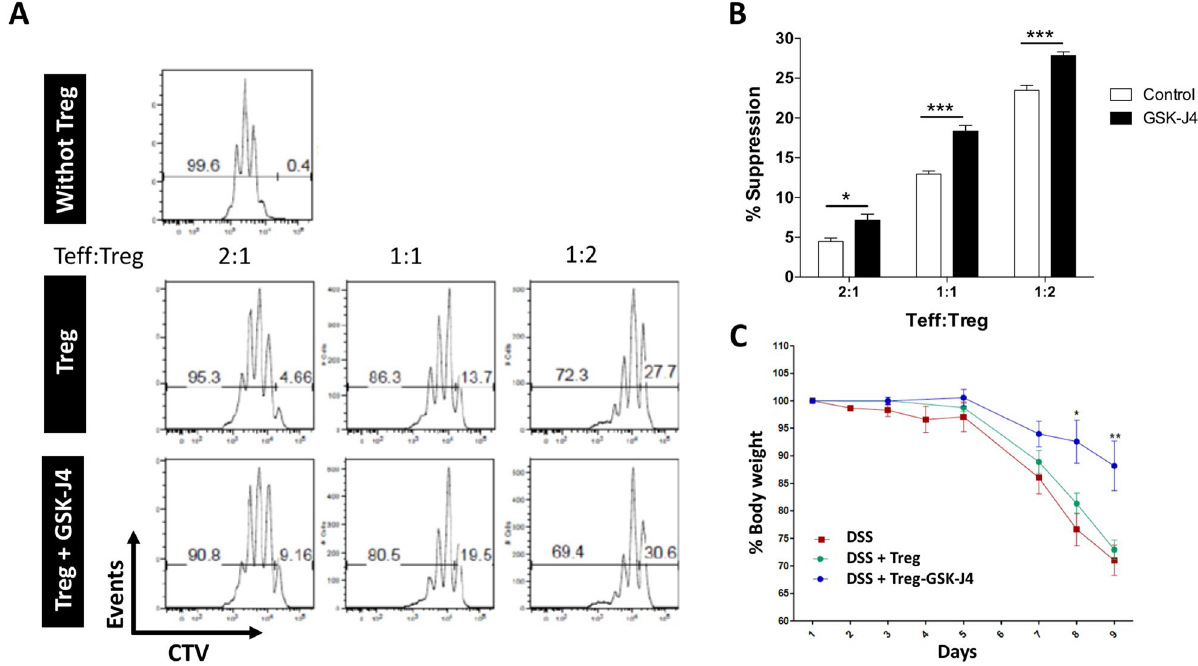
Figure 6. DCs exposed to GSK-J4 generate Treg with higher suppressive activity. Naïve CD4 + CD25 − Foxp3 − T cells were isolated from Foxp3 GFP mice by cell-sorting and activated with splenic DCs and anti-CD3 Ab under standard Treg polarising conditions in the absence (Control) or the presence of GSK-J4 25 nM. After 5 days of culture, GFP + Treg cells were purified by cell-sorter and their suppressive activity was analysed in vitro ( A , B ) and in vivo ( C ). ( A , B ) Effector CD4 + CD25 − T cells (Teff) were loaded with 5 μM CTV and activated with DCs and anti-CD3 Ab in the presence of Treg (at different Teff:Treg ratios). Three days later, Teff proliferation was quantified as the dilution of CTV-associated fluorescence by flow cytometry. As a control to determine the maximal Teff proliferation, Teff were activated in the absence of Treg (without Treg). ( A ) Representative histograms of CTV dilution profiles are shown. Markers show the population of Teff displaying CTV dilution (left markers) and Teff displaying no CTV dilution (right markers). The percentages of cells covered by each marker are indicated. ( B ) The extent of suppression is quantified as the percentage of inhibition of Teff proliferation relative to maximal proliferation (without Treg). Data represent mean ± SEM from three independent experiments. ( C ) Treg were i.v. transferred (7.5 × 10 5 cells per mouse) into WT recipient mice which simultaneously received 1.5% DSS during 8 days. Bodyweight changes respect to the initial weight was calculated throughout the time-course of disease development. Data represent mean ± SEM from 4 mice per group. * p < 0.05; ** p < 0.01; *** p < 0.001 when Treg and Treg + GSK-J4 groups are compared as determined by Student’s t-test ( B , C